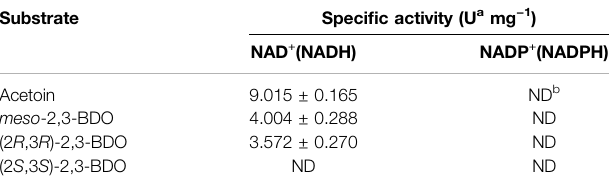
TABLE 2 | Identi fi cation of the cofactor of R , R -BDH. Substrate